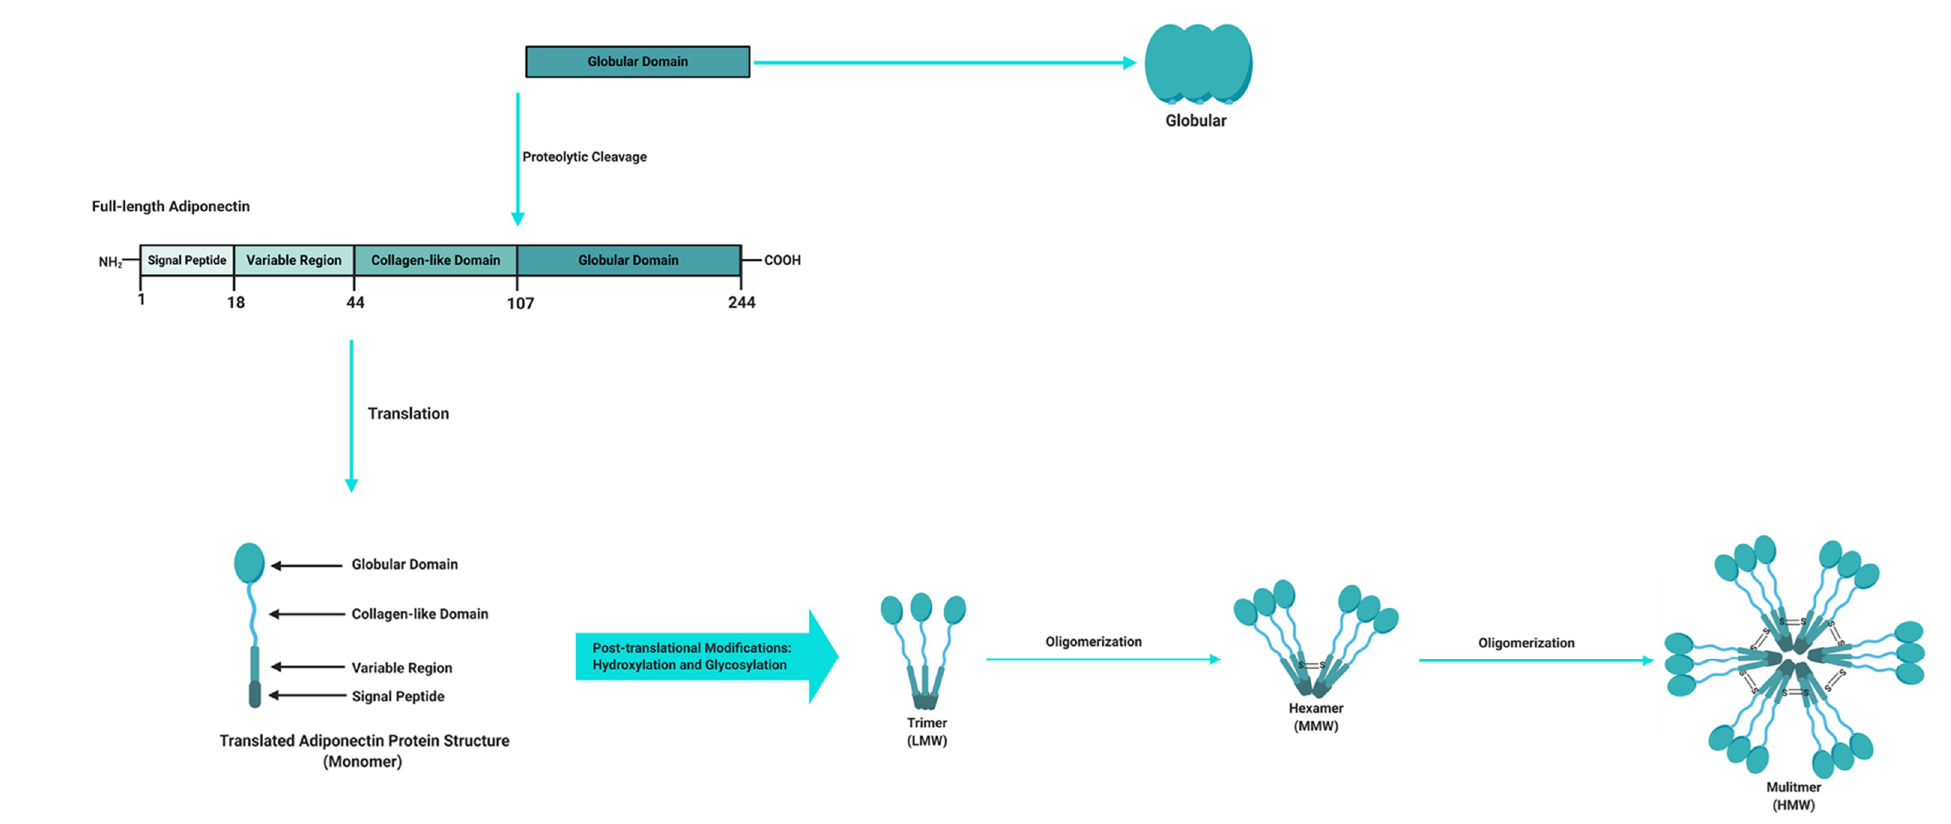
Figure 2. Adiponectin domains and molecular structure. The full-length structure of adiponectin is composed of a 244 amino acid protein mainly synthetized by adipocytes as a single subunit containing an N-terminal signal peptide, a variable region, a collagen-like domain and a globular domain at the C-terminus. Before it is secreted to the circulation, adiponectin undergoes oligomerization to form trimers (low molecular weight (LMW)), hexamers (medium molecular weight (MMW)), and multimers (high molecular weight (HMW)). Adiponectin is also present in plasma as a globular isoform synthesized by the proteolytic cleavage of the globular domain of the full-length adiponectin protein. Figure adapted and modified [20,22], and created with BioRender.com.